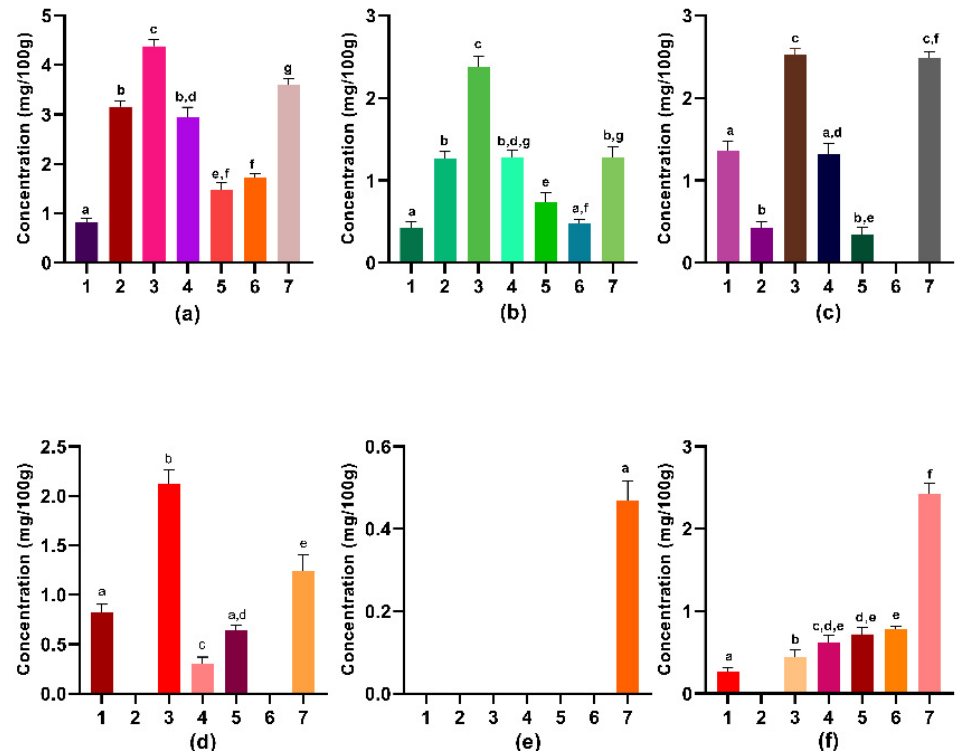
Figure 5. Selected nutraceuticals found in the edible plant organs from Solanum nigrescens ( 1 ), Sechium edule ( 2 ), Rumex obtusifolius ( 3 ), Amaranthus hybridus ( 4 ), Piper auritum ( 5 ), Rhamnus pompana ( 6 ), and Yucca aloifolia ( 7 ). The content of quercetin ( a ), kaempferol ( b ), lutein ( c ), β -cryptoxanthin ( d ), α -carotene ( e ), and β -carotene ( f ) is shown. Different letters indicate means ( n = 15) with statistically significant differences by ANOVA–Tukey’s test at p < 0.05. Detailed information can be found in Table S4.